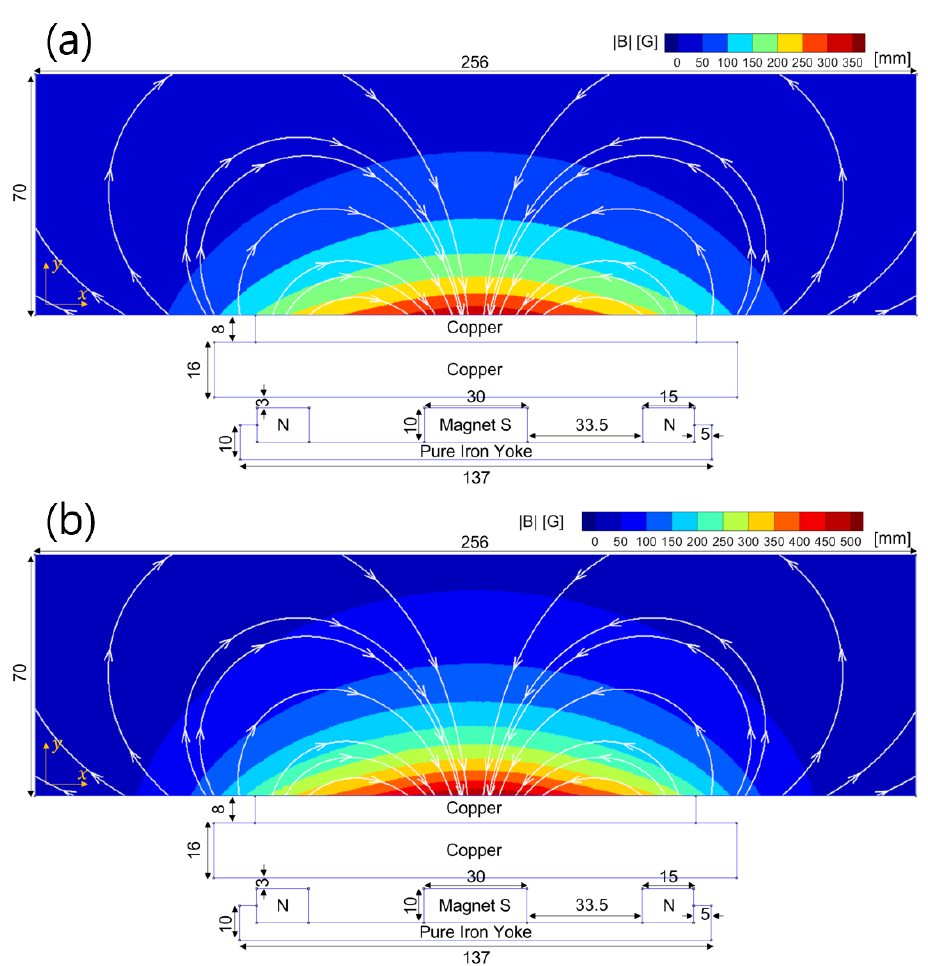
Figure 2. Magnetic fields with the maximum magnetic flux density of ( a ) 350 G and ( b ) 500 G .